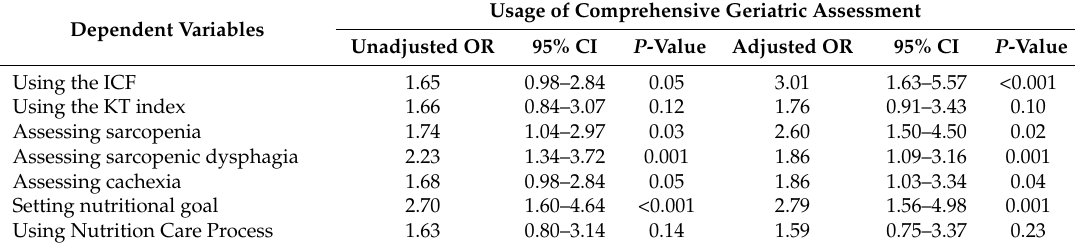
Table 3. Odds Ratio of Comprehensive Geriatric Assessment Usage in Uni- and Multi-Variate Logistic Regression